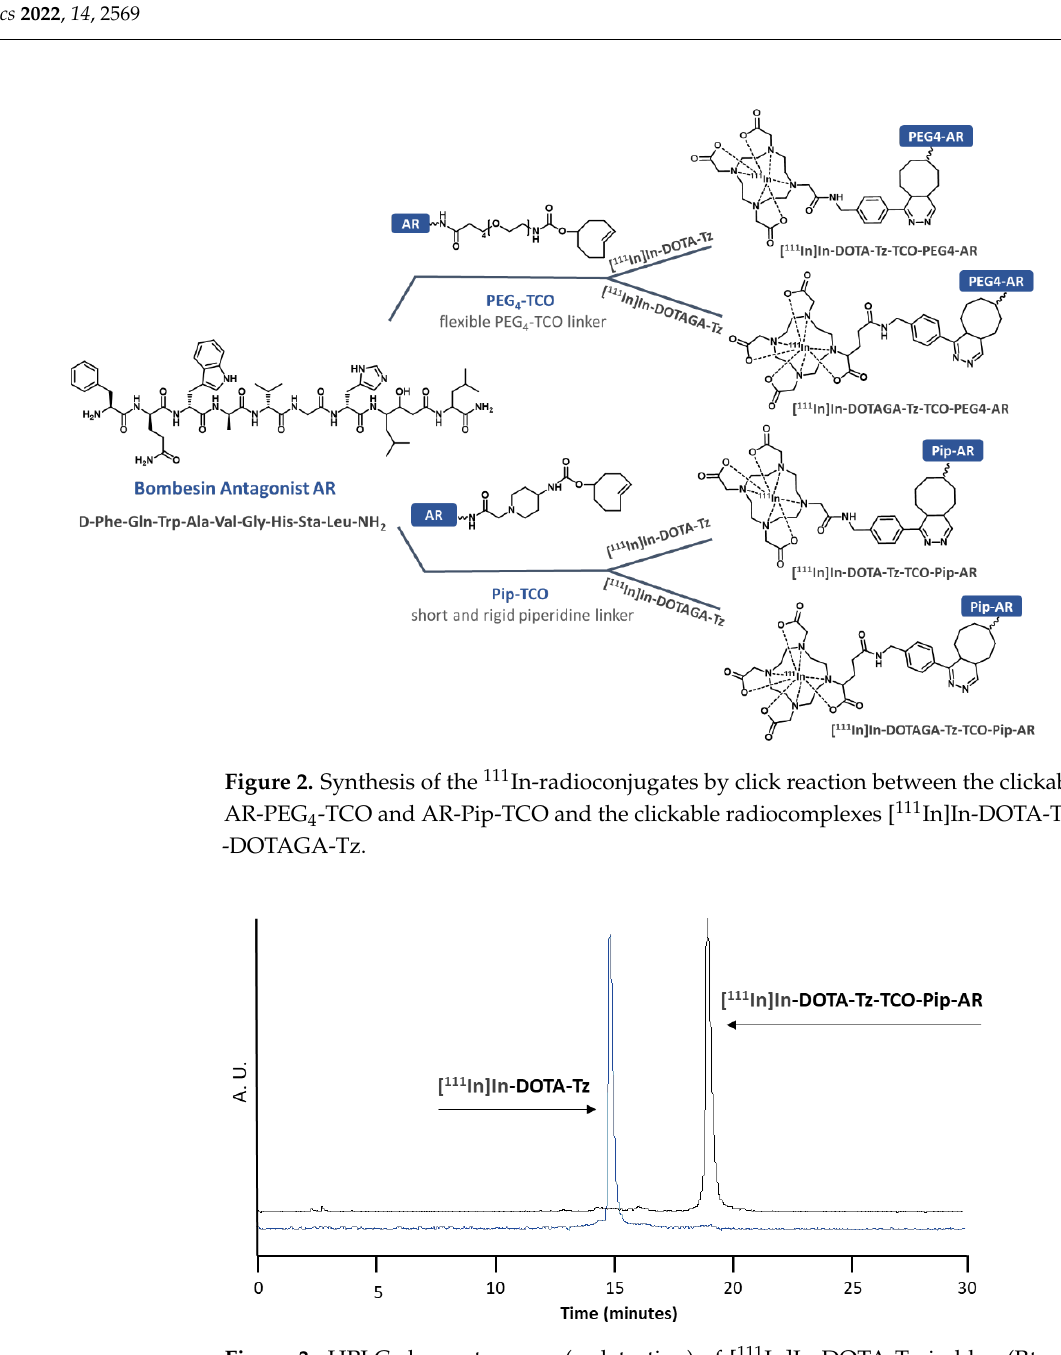
Figure 3. HPLC chromatograms ( γ -detection) of [ 111 In]In-DOTA-Tz in blue (Rt = 14.8 min) and 111 In- DOTA-Tz-TCO-Pip-AR in black (Rt = 19.1 min). 111 In-DOTA-Tz-TCO-Pip-AR in black (Rt = 19.1